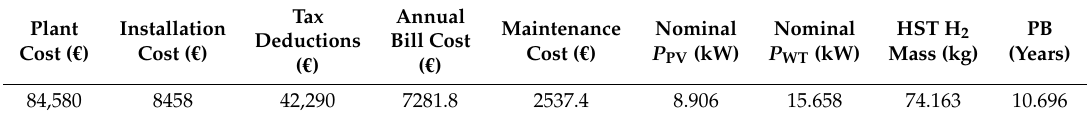
Table 3. Constrained optimization (see Section 3.2) outcomes in terms of costs ( € ) and nominal microgrid component power /